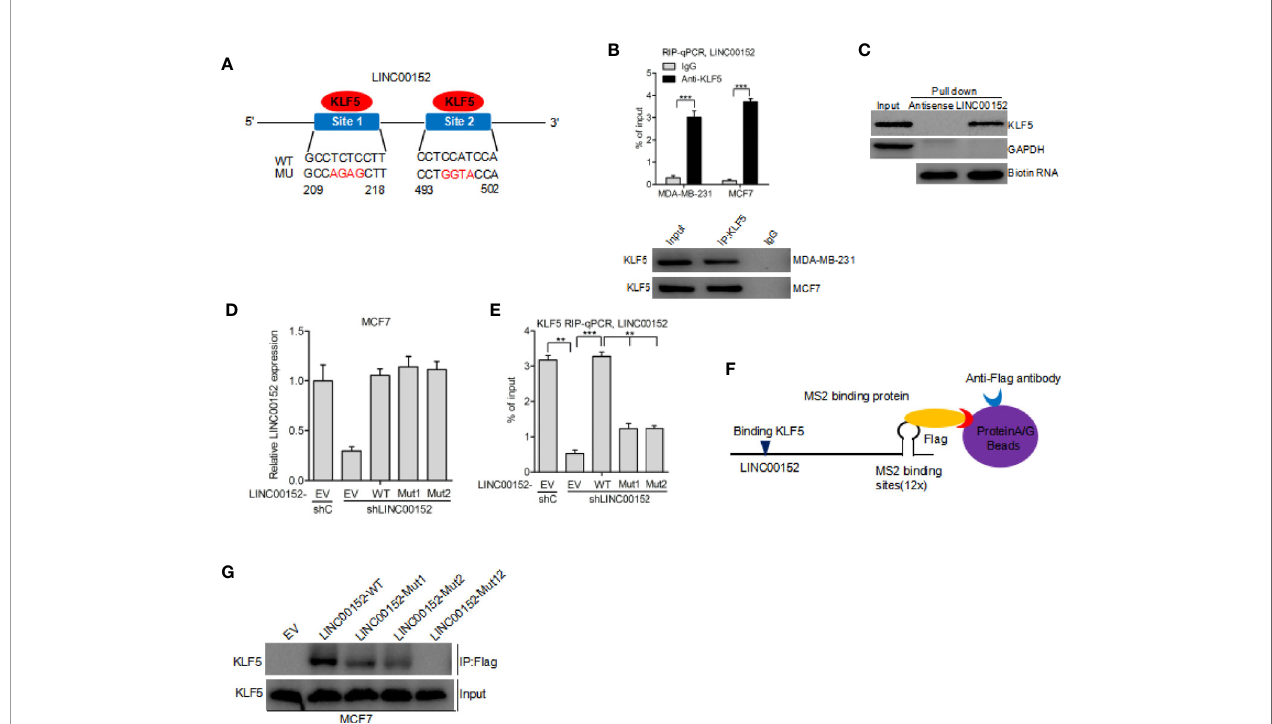
FIGURE 3 | LINC00152 interacts with KLF5 in breast cancer. (A) Schematic diagram of putative KLF5 binding sites in LINC00152. (B) RIP-qPCR assay of the association of KLF5 with LINC00152 in MDA-MB-231 and MCF7 cells. (C) RNA pull-down assay shows that LINC00152 binds to KLF5. (D) Re-expression of shRNA-resistant LINC00152 wild type and KLF5-binding mutant types. (E) RIP-qPCR assay of effects of re-expression of shRNA-resistant LINC00152 wild type or mutant types on KLF5 binding. (F – G) Western blot detection of KLF5 after Flag-MS2bp-MS2bs-based pull-down assay (22). EV, empty vector. **P < 0.01, ***P < 0.001. Error bars represent SD. Data are representative of two or three independent